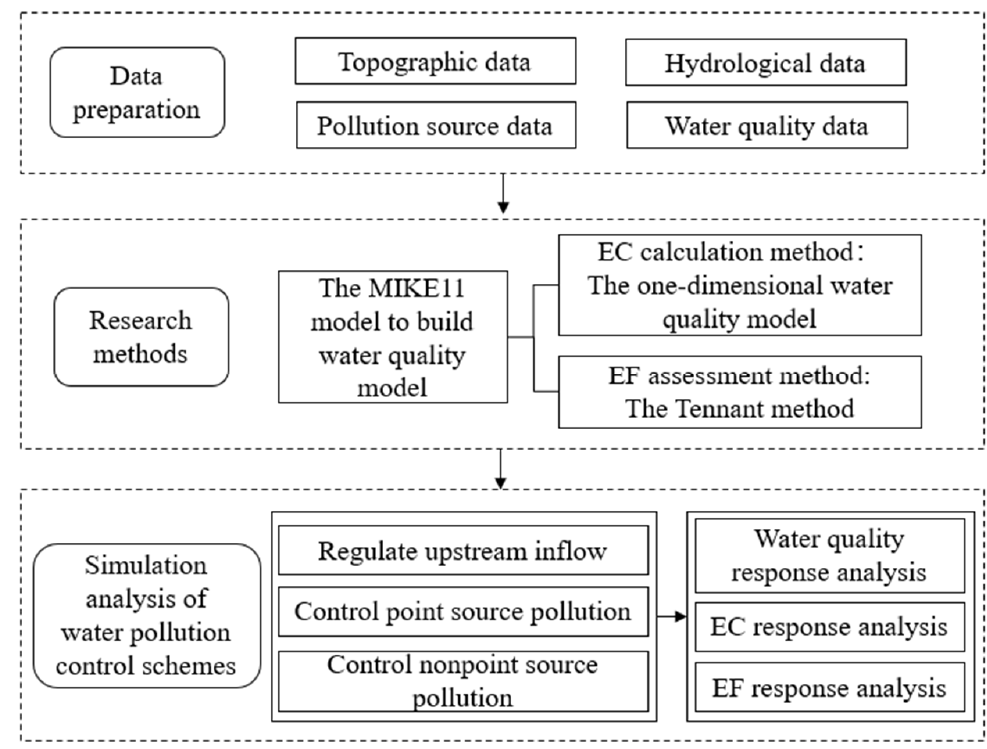
Figure 2. Technical roadmap.